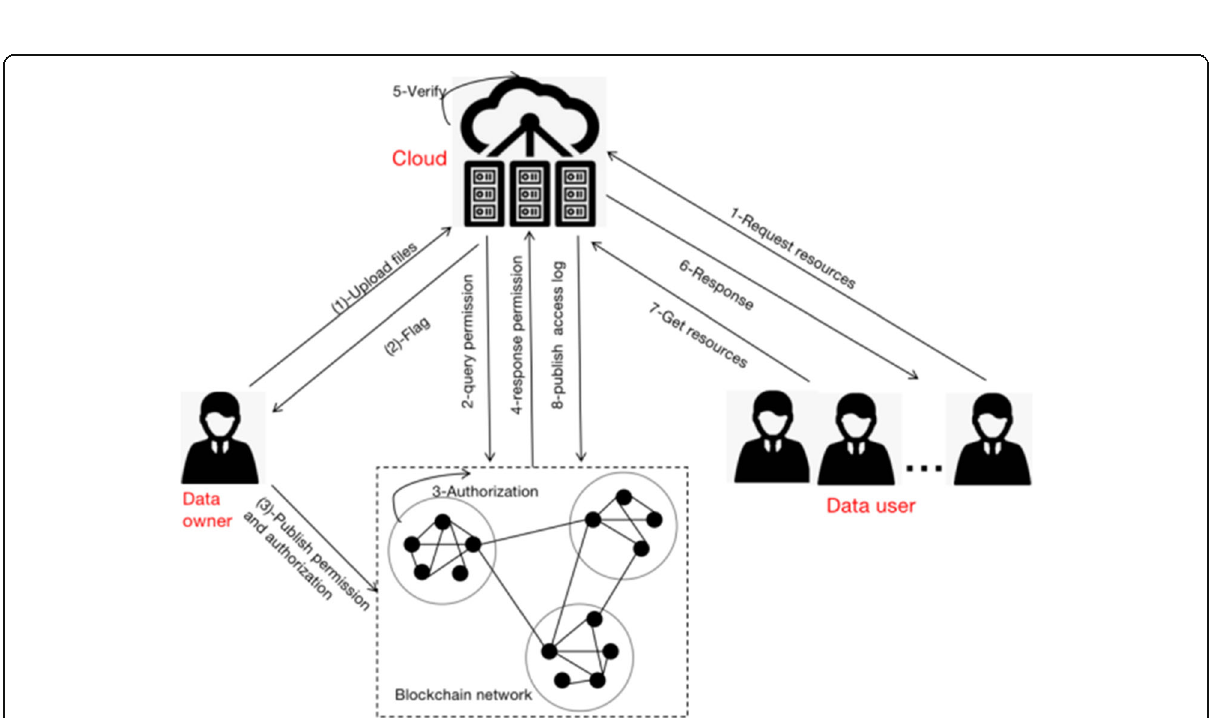
Fig. 12 Main authentication process of AuthPrivacyChain